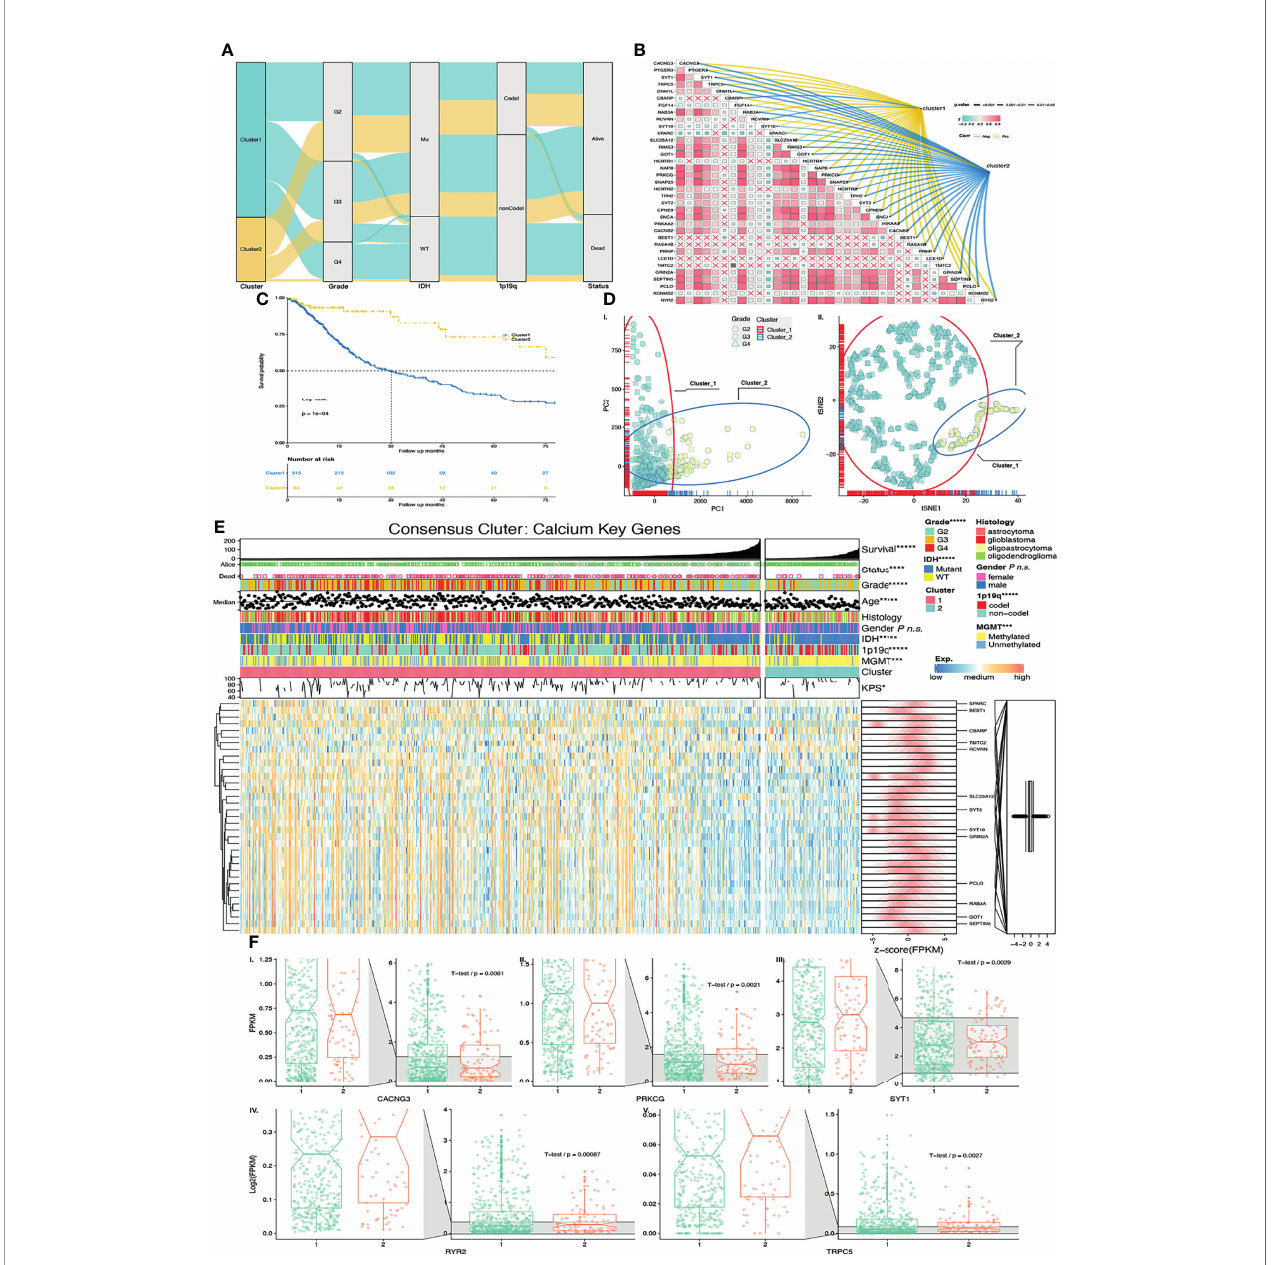
FIGURE 3 | Validation of unsupervised learning. (A) Alluvial diagram of CKG clustering distribution in groups with different clusters, glioma grade, IDH status, 1p19q codeletion status, and survival outcomes. (B) Correlation among CKGs was exhibited in a heatmap. Correlation between CKGs and clusters was exhibited on colored (positive correlation = yellow, negative correlation = blue) links with p values as size of line. (C) Kaplan – Meier curves for Cluster 1/2 in TCGA cohort. Log-rank test, p = 0.0001. (D) External unsupervised learning method of (I.) PCA and (II). tSNE-validated consensus clustering. Clusters 1/2 and glioma grades were mapping in different colors and shapes of the points. (E) Heatmap of CKGs with clinical features and clusters. TCGA-DEGs were marked. (F) CKG expression values with signi fi cant expression between Cluster 1/2 (I – V.). *p < 0.05; ***p < 0.001; ****p < 0.0001; *****p < 0.00001; ns p >